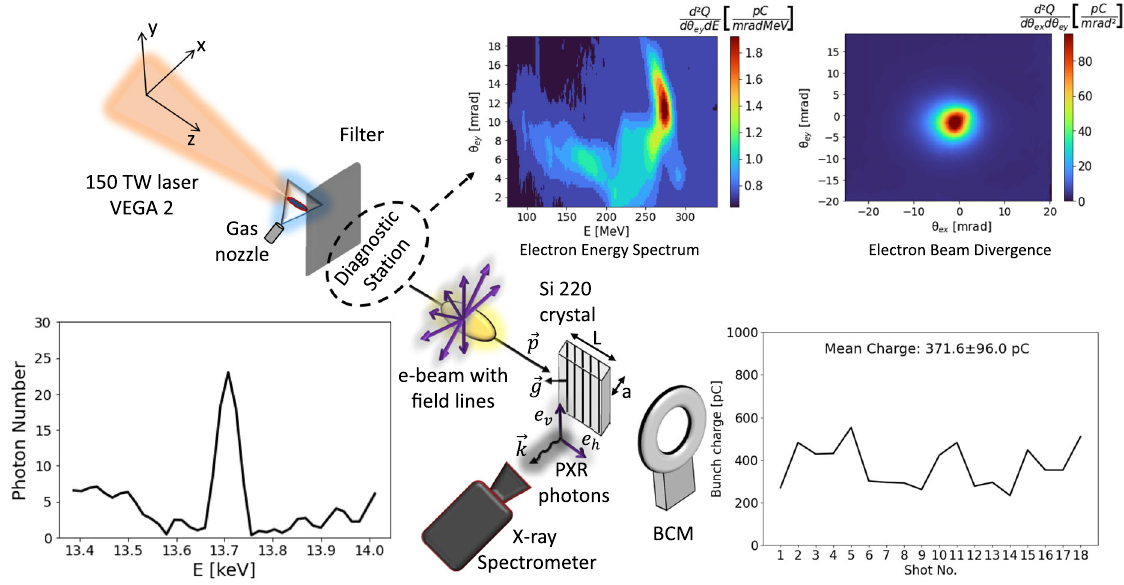
FIG. 2. Experimental setup and geometry for PXR emission by laser-produced electron beams at VEGA